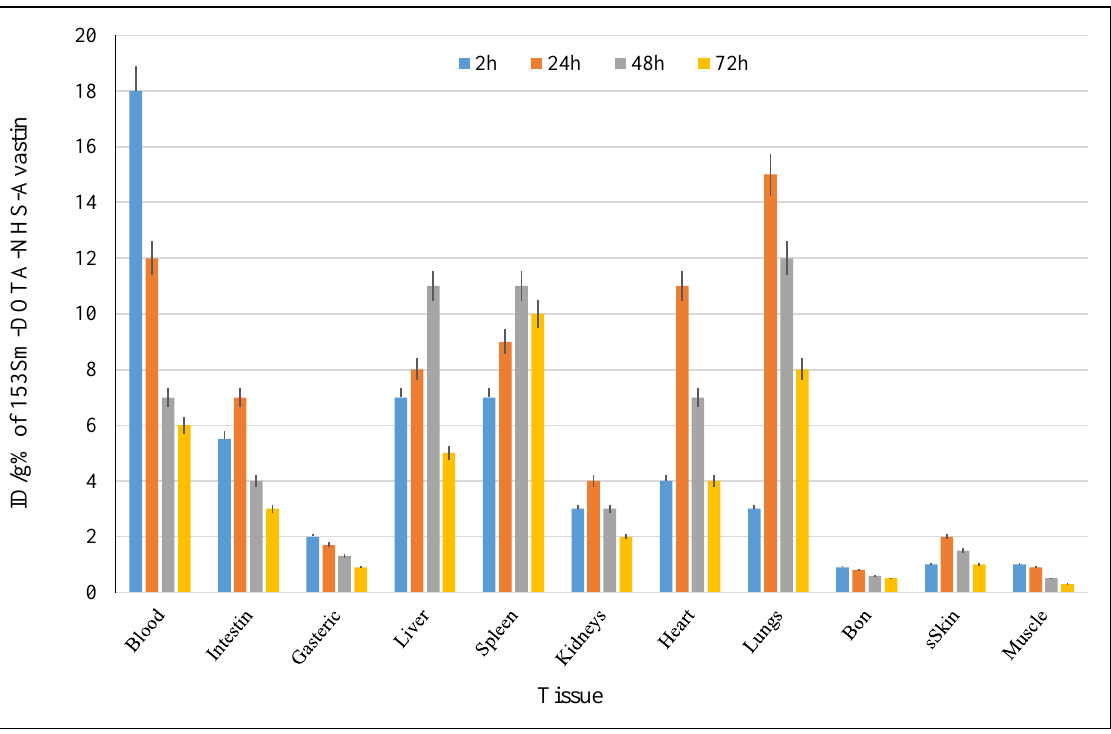
Figure 6B. Tissue distribution of 153 Sm activity in normal mice after injection of 153 Sm-DOTA-avastin values are presented as percent injected dose per gram of tissue (%ID/g, n =